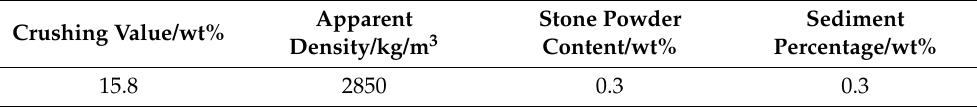
Figure 2. Particle size distribution of waste rock. Table 1. Technical characteristics of graded waste rock.